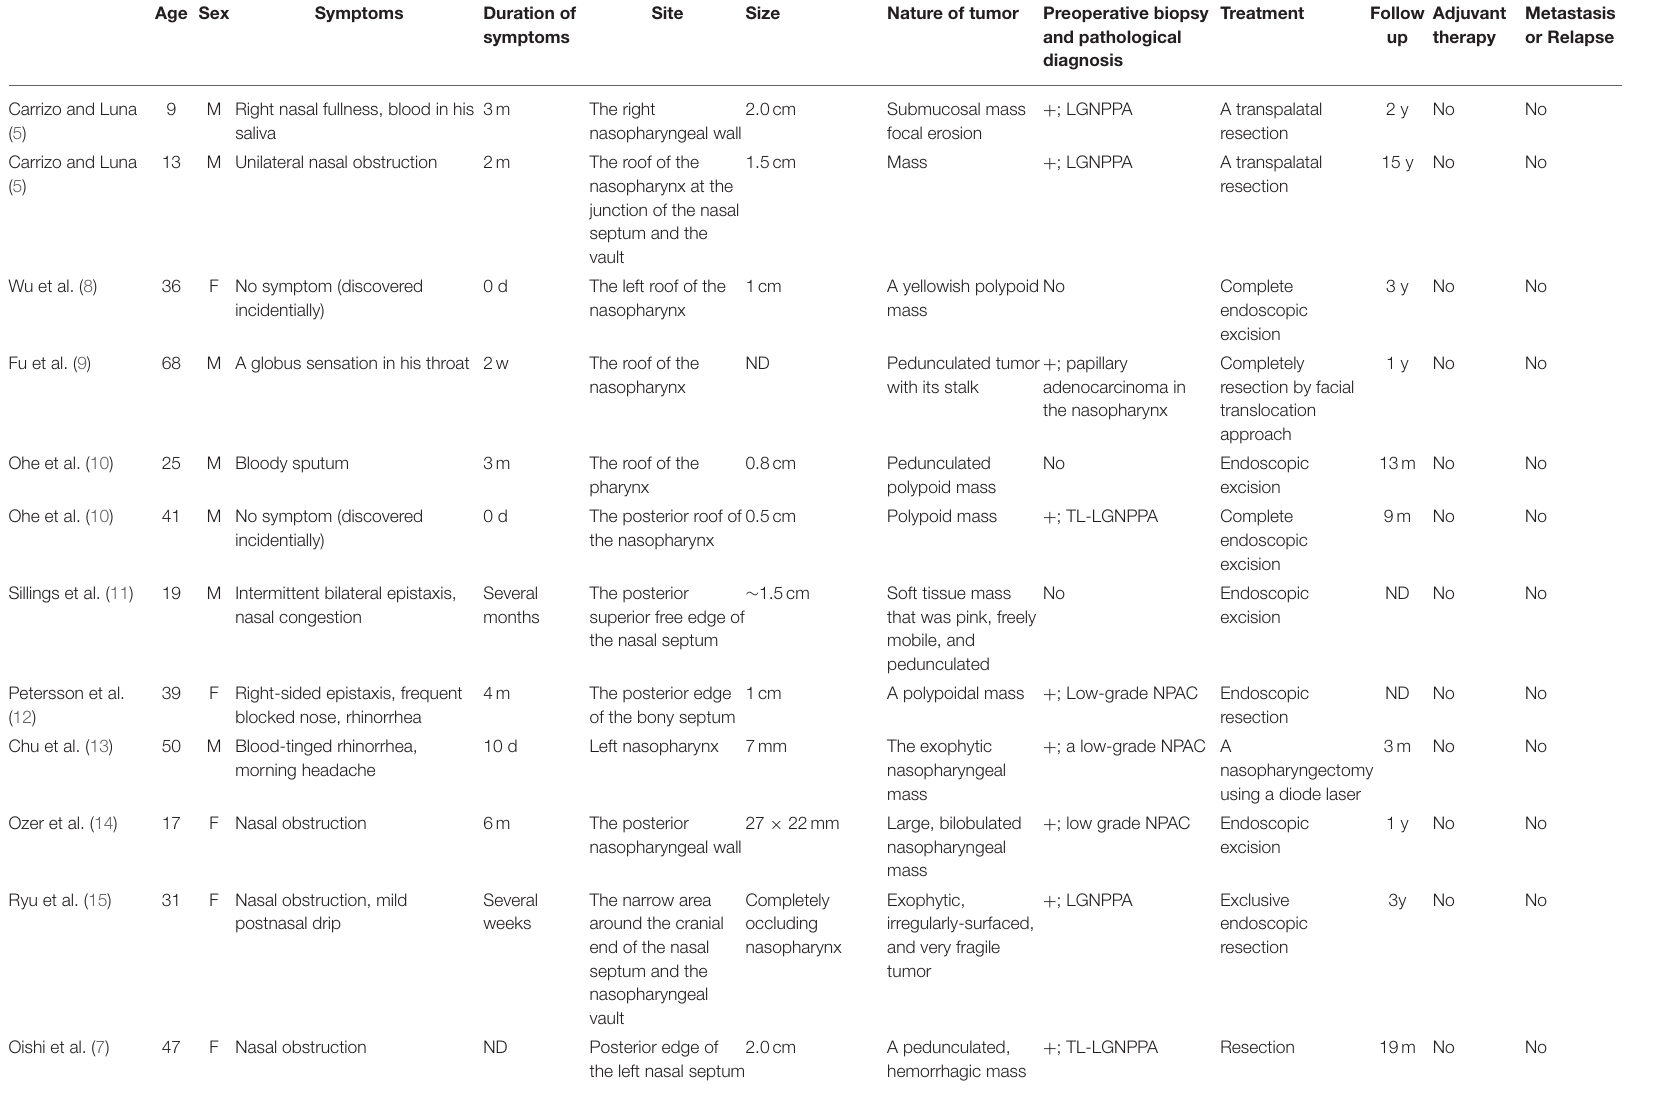
TABLE 1 | Summary of clinical characteristics of previously reported thyroid-like low-grade nasopharyngeal papillary